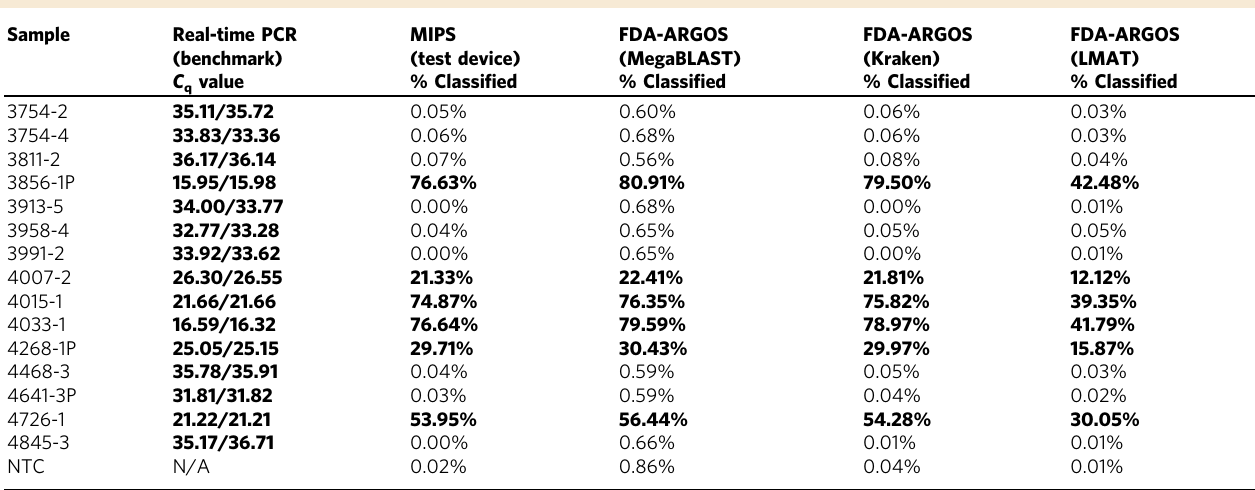
Table 2 Zaire ebolavirus Makona performance summary